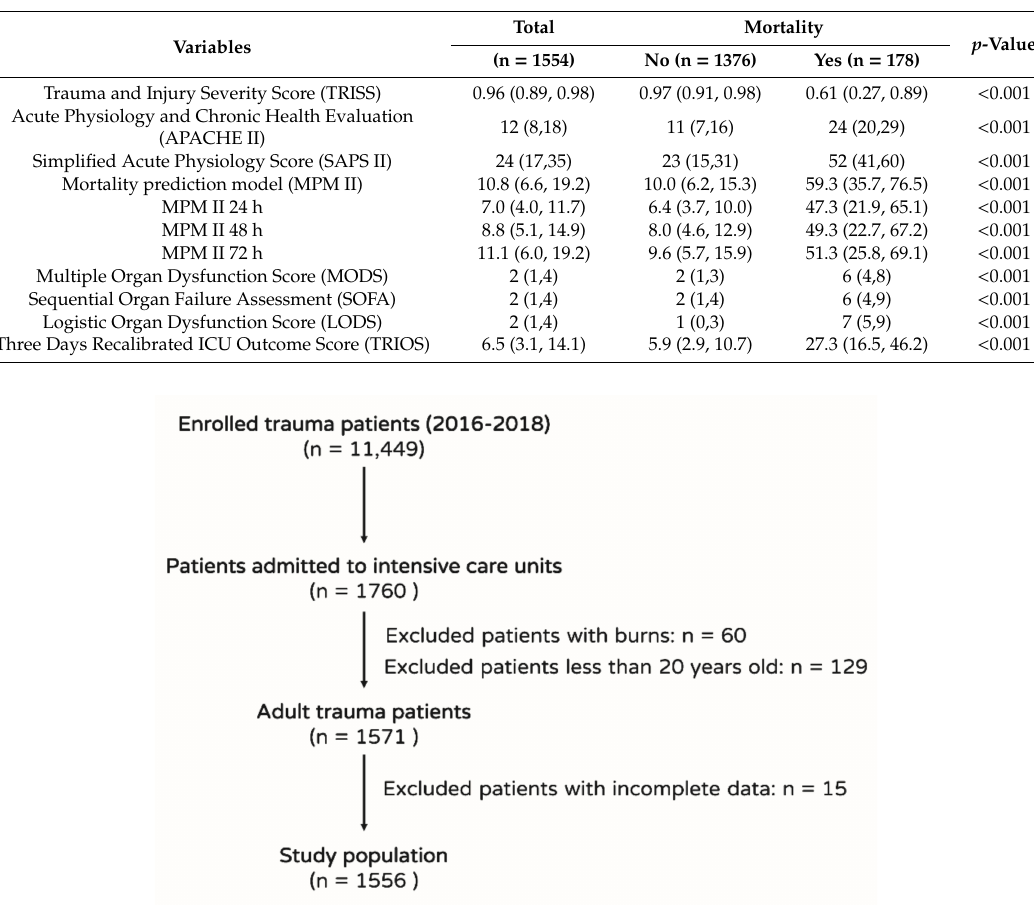
Table 3. Comparison of the prognostic scoring systems in critically ill trauma patients who died or survived.